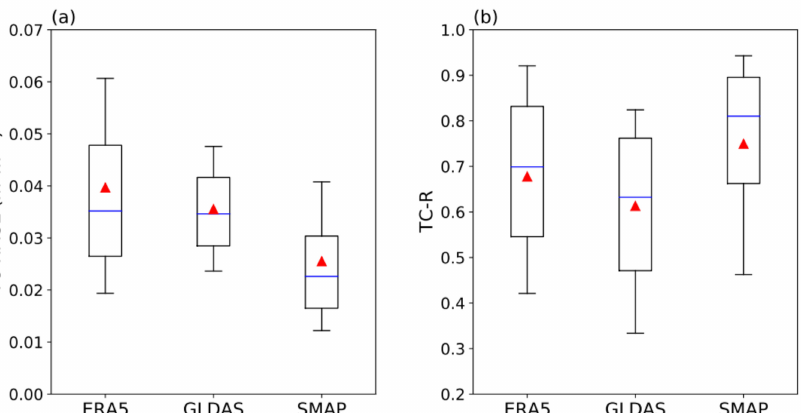
Figure 7. Boxplots of ( a ) the standard deviation of random errors derived from triple collocation (TC-RMSE) and ( b ) triple collocation correlation coefficients (TC-R) for all grids in the three products. Blue line indicates the median. Triangle indicates the mean. Bottom and top horizontal lines indicate the 10% and the 90% quantiles,